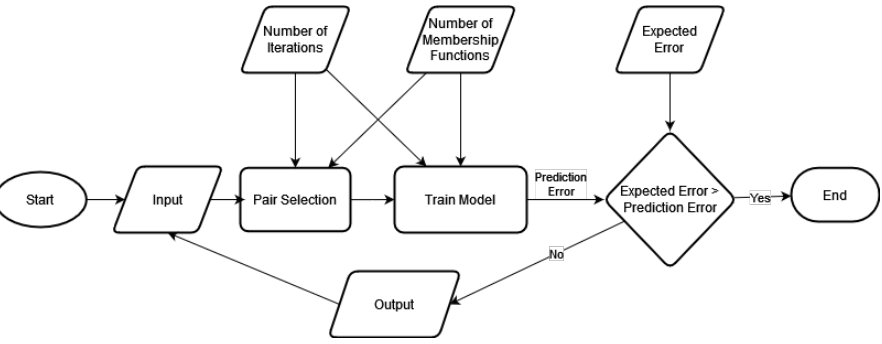
Figure 2. Flowchart of the Cascaded